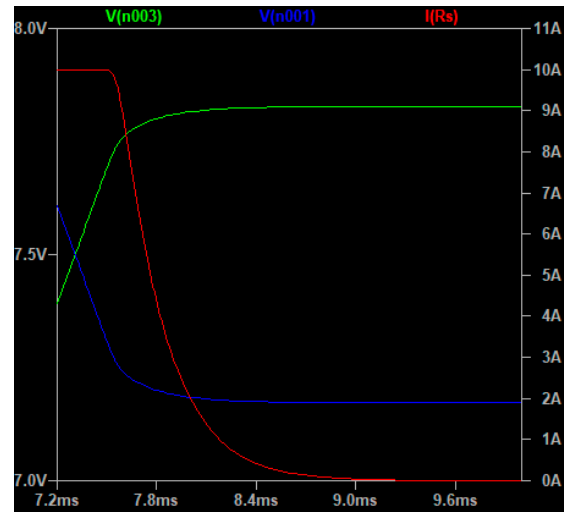
Figure 8. Zoomed graph of the most interesting zone of the discharge of C 1 and the charge of C 2 across the DUT. Current flow (red line), voltage of C 1 (blue line), and voltage of C 2 (green line) over time.